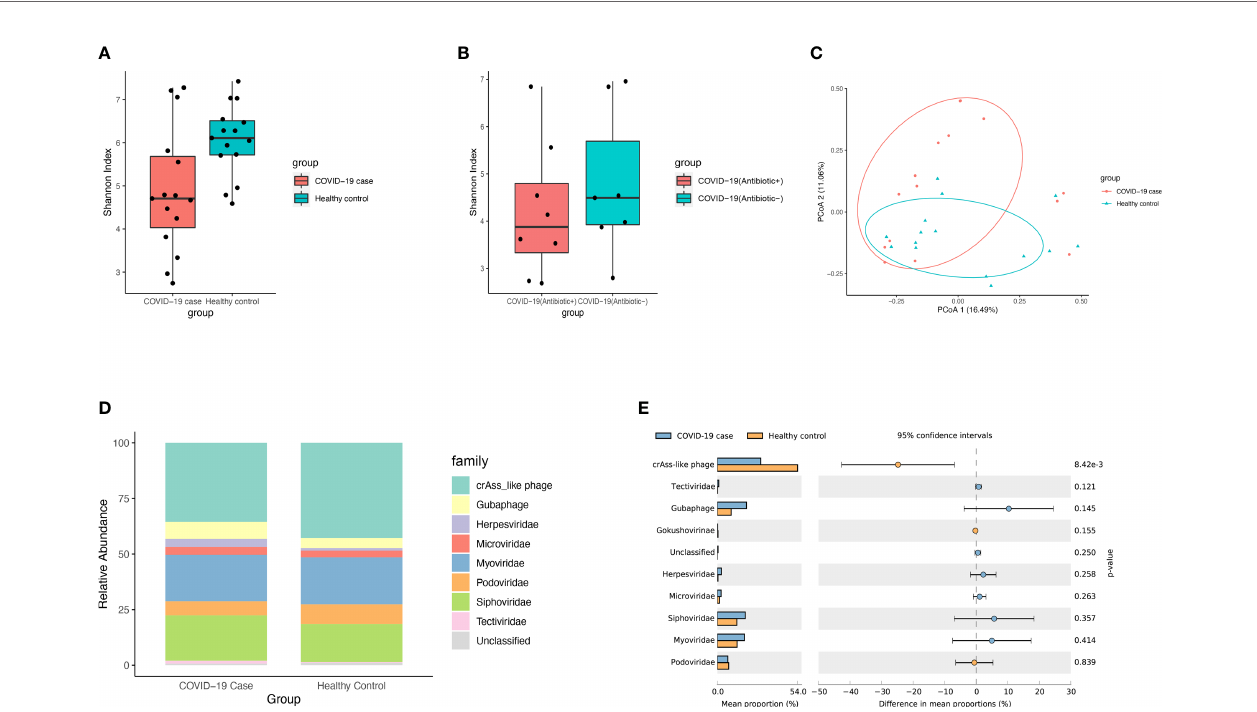
FIGURE 1 | Viral diversity and composition of microbial community. (A) Boxplot showed viral alpha diversity between COVID-19 patients and healthy controls based on the Shannon index. The dot points represent the index of each of samples. (B) Boxplot showed viral alpha diversity between COVID-19 patients with antibiotic treatment(Antibiotic+) and those without antibiotic treatment(Antibiotic-) based on the Shannon. (C) PCoA analysis based on Bray-Curtis distance between COVID- 19 patients and healthy controls in the relative abundance of virome. The dot points represent the distance of each of samples from the two most explainable dimensions. (D) Viral community structural composition and distribution on family level. The Stack bar diagram represent the percent of taxonomical composition in two groups. (E) The extended error barplot shows the abundances of different viral abundances in the two groups of samples. The middle shows the abundances of different species within the 95% con fi dence intervals. The value on the far right is